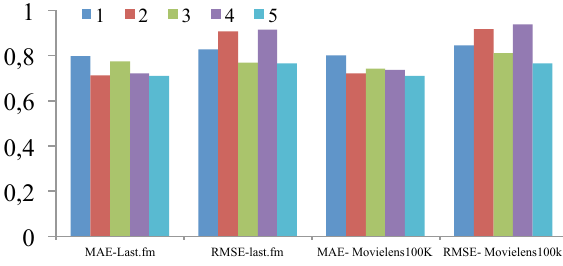
Figure 3. Comparison for MAE and RMSE values with existing methods on last.fm and Movie lens data sets This proves that one can combine sequential